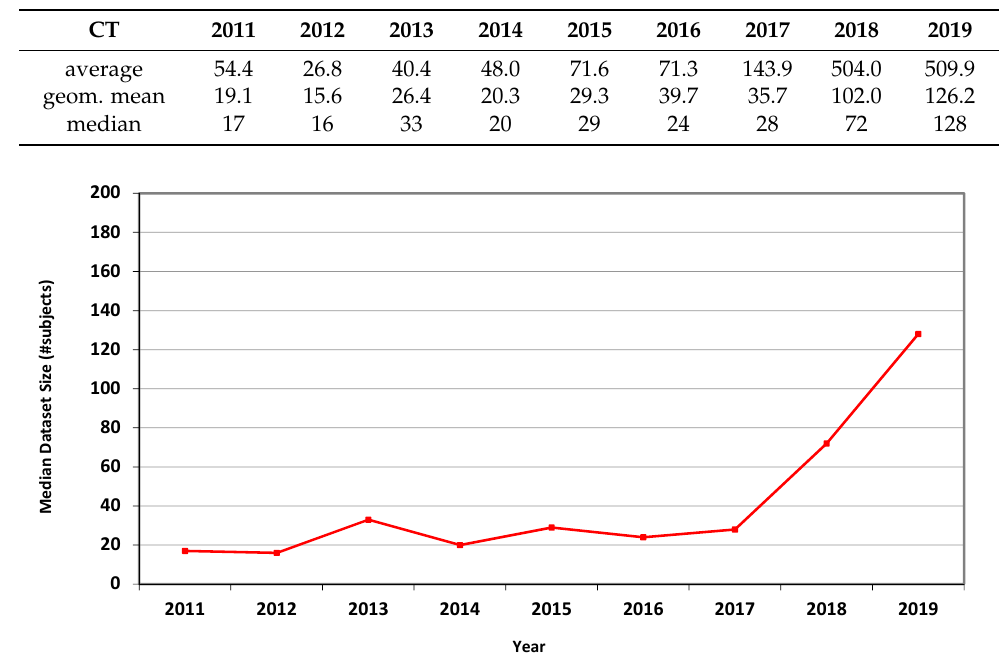
Figure 3. Median size of datasets used in MICCAI articles related to fMRI in each of the years 2011– 2019. 4. Statistical Analysis and Prediction—Phase I (2011–2018 Data) As a preliminary test of the dataset growth hypothesis, we first divided the range of years into two categories: 2011–2014 and 2015–2018. The distributions of the dataset sizes in the two categories were similar and non-normal. A Mann–Whitney U test was carried out to determine if there were differences in dataset sizes between the two time-categories. •